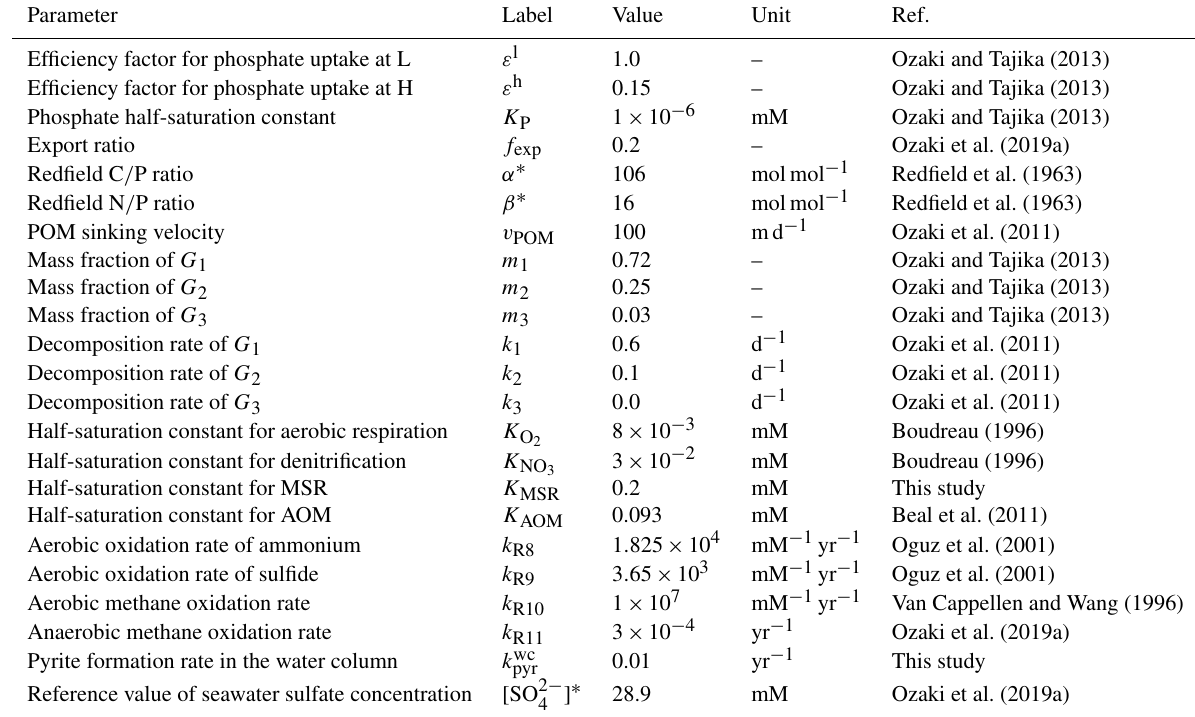
Table 4. Parameter values used in the oceanic biogeochemistry module of CANOPS-GRB.